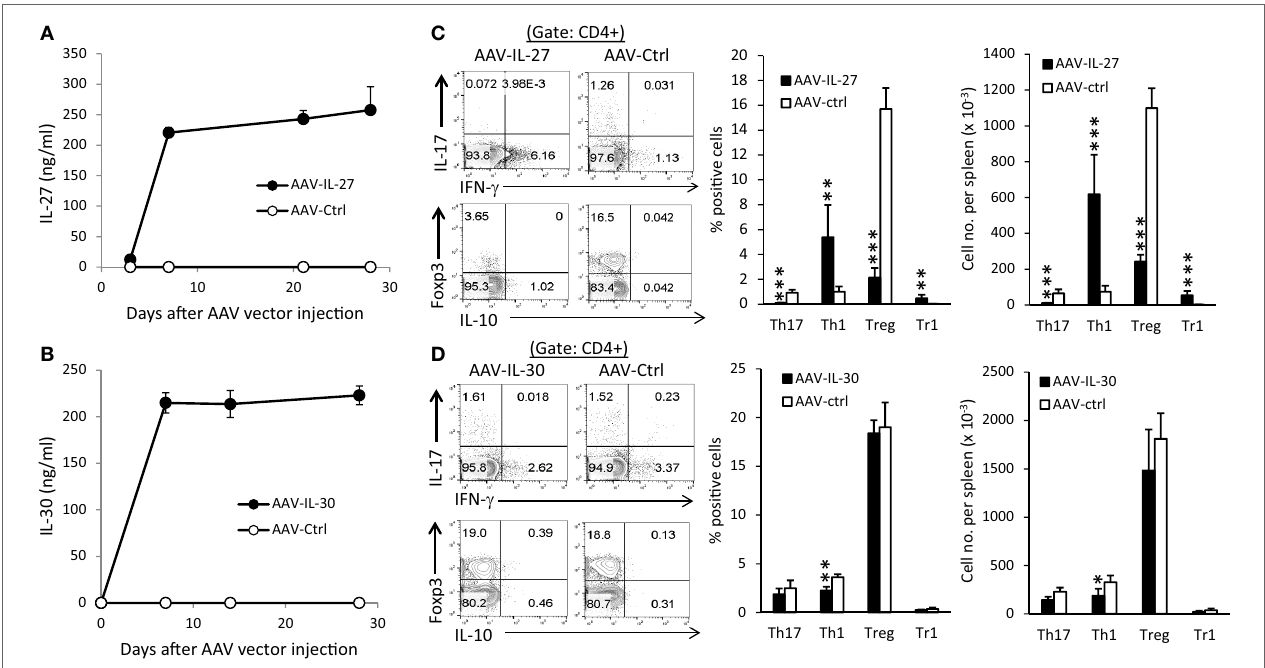
FigUre 1 | Adeno-associated viral vector (AAV) mediated delivery of interleukin-27 (IL-27)/IL-30 and their impacts on T cell subsets. C57BL6 mice ( n = 5/group) were treated with AAV-IL-27, AAV-IL-30, or AAV-ctrl virus i.m. at a dose of 2 × 10 11 DRP/mouse. IL-27 (a) or IL-30 (B) levels in blood were detected by ELISA. Two weeks after AAV injection, mice ( n = 5/group) were sacrificed and CD4 + T cells in spleens from AAV-IL-27 (c) or AAV-IL-30 (D) treated mice were analyzed and quantified by flow cytometry. Data shown represent two (a,B) and three (c,D) experiments with similar results. Statistical analysis was performed using the unpaired Student’s t -test. * P < 0.05; ** P < 0.01; *** P <